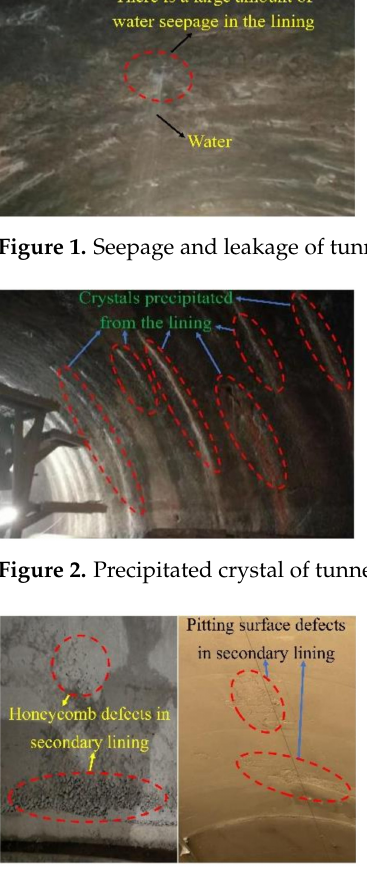
Figure 3. Tunnel second lining